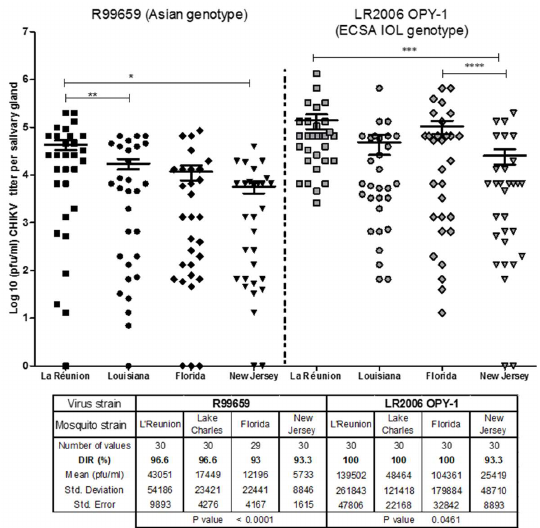
Figure 1. Chikungunya virus (CHIKV) disseminated infection rates (DIR) and titer in salivary glands of four Ae. albopictus strains. Aedes albopictus were orally infected with either CHIKV R99659 (blood titer 5.6 × 10 7 pfu/mL) or CHIKV LR2006 OPY1 (blood titer 6.6 × 10 7 pfu/mL) and the DIR (prevalence) and virus titers were determined 9 days post infection in salivary glands by plaque assay. The number of mosquitoes assayed from each mosquito and CHIKV strain and the prevalence (% infection) are listed. Horizontal bars show mean titer values with standard error of the mean (SEM). p -values of virus titers among the Ae. albopictus strains infected with either R99659 or LR2006 OPY1 are shown in table. * p = 0.0010, ** p = 0.0181, *** p = 0.0330, **** p =